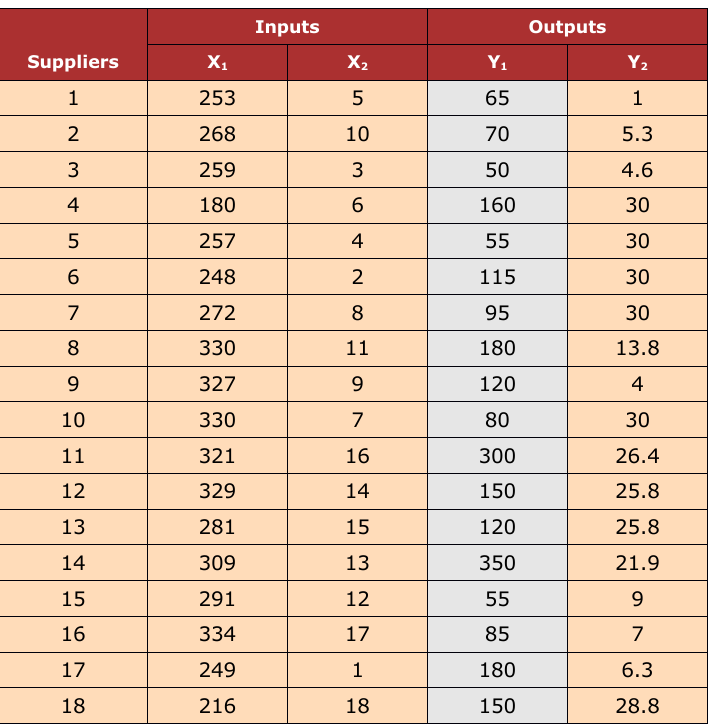
Table 5. Original values for α =